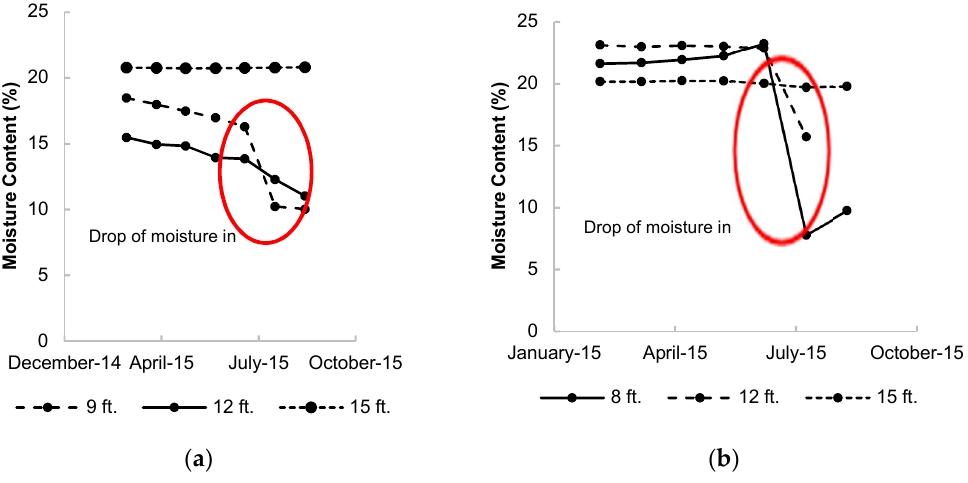
Figure 7. Drop of moisture content after summer at two boreholes of SH 342.